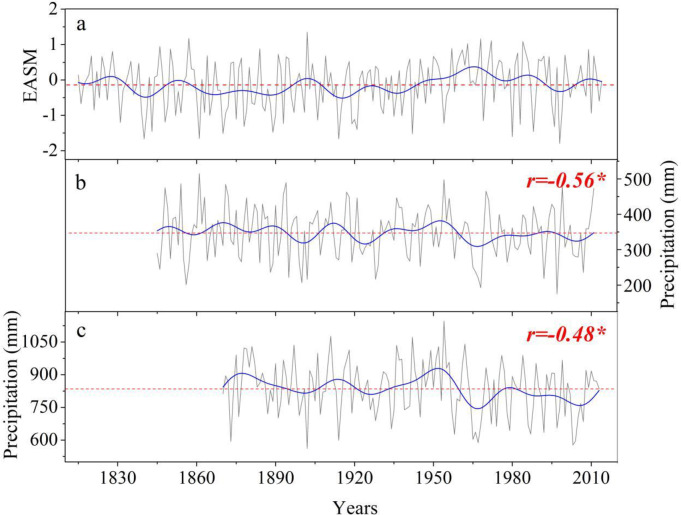
Comparison of (a) the reconstructed EASM with the tree-ring δ18O based (b) May-June precipitation reconstruction for BMJ [31] and (c) May-October precipitation reconstruction for AJ [30] over the middle-lower reaches of the Yangtze River. The low-frequency variations isolated by using a 20-year fast-Fourier transform filter are represented by the solid blue lines.